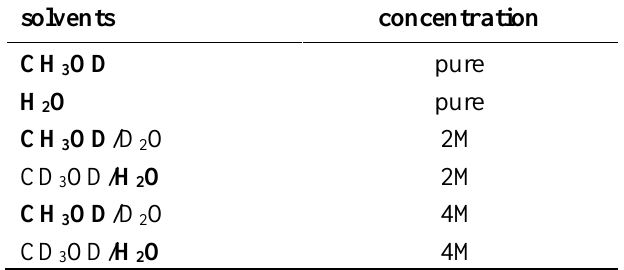
Table 2. Solvents and solutions used to prepare swollen membranes for the NMR study. solvents